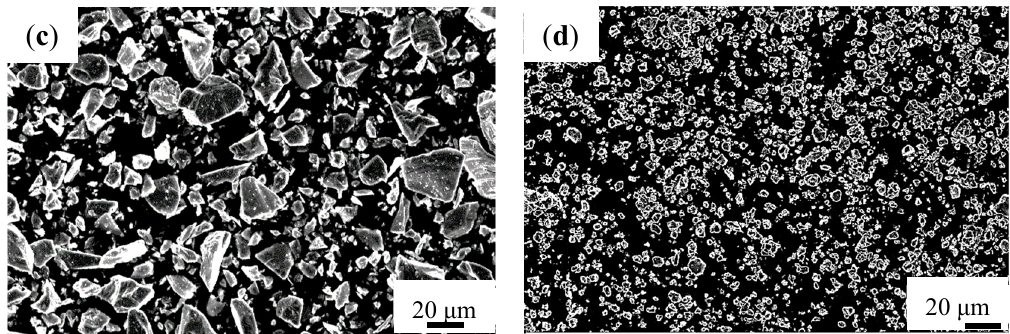
Figure 1. Morphologies of powders ( a ) Ti; ( b ) Al; ( c ) Si and ( d ) TiC. To compare with the generated phases in composite coating, the XRD patterns of the as-milled Ti-Al-Si based powders are shown in Figure 2. The index of XRD peaks suggests that hcp-Ti, fcc-Al and diamond structure Si exist in all laser cladding powders. The weak diffraction peaks of TiC only present at about 42 ° in the XRD pattern of Ti-Al-Si-2TiC, owing to the low content of TiC (only 2 wt.%). However, the diffraction peaks of TiC can be clearly detected in the XRD patterns of Ti-Al-Si-6TiC and Ti-Al-Si-10TiC powders, as shown in 42 ° , 61 ° , and 73 ° .